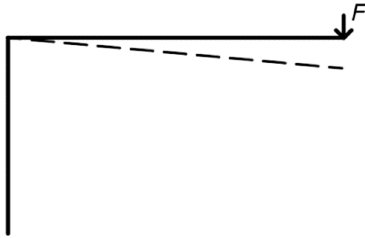
Figure 7. Deformation of the rung end caused by the rotational stiffness of the frame connection.